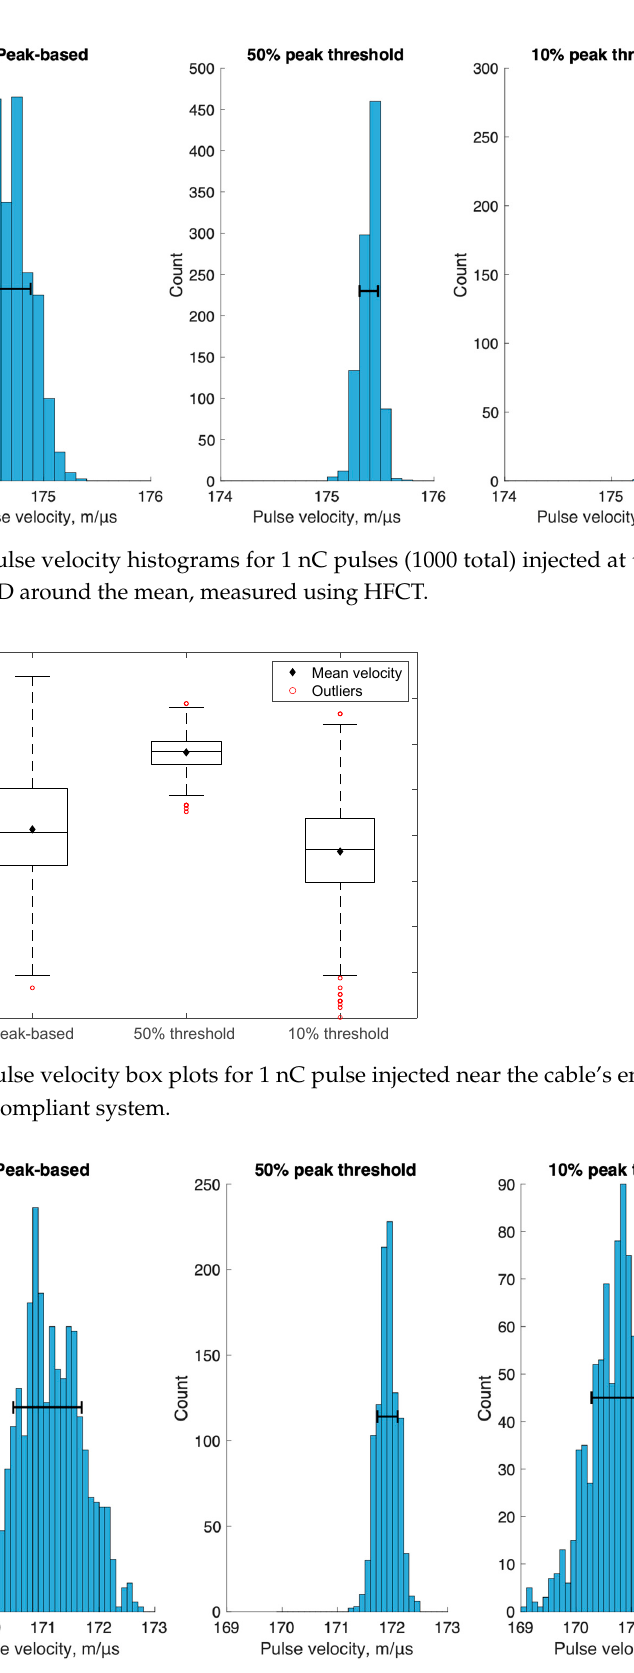
Figure 10. Pulse velocity box plots for 1 nC pulse injected at the far end of the cable, measured using the IEC 60270-compliant system. Peak-based